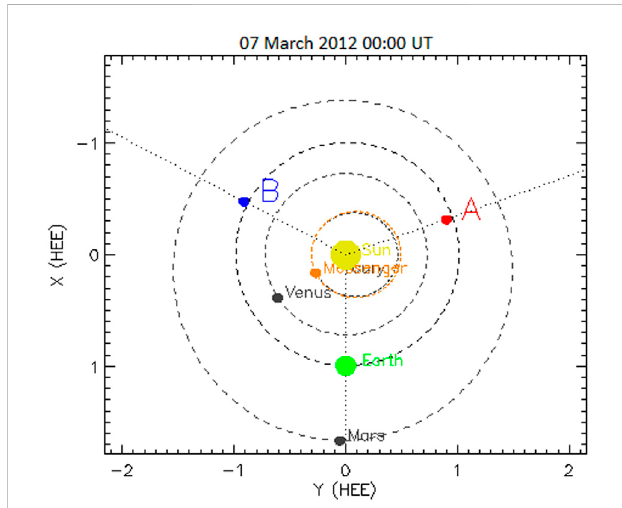
FIGURE 1 Position of STEREO-B is shown with the blue circle; STEREO-A, with red; Mercury (MESSENGER — orange); Venus; Earth (green circle); and Mars on 7 March 2012 00:00